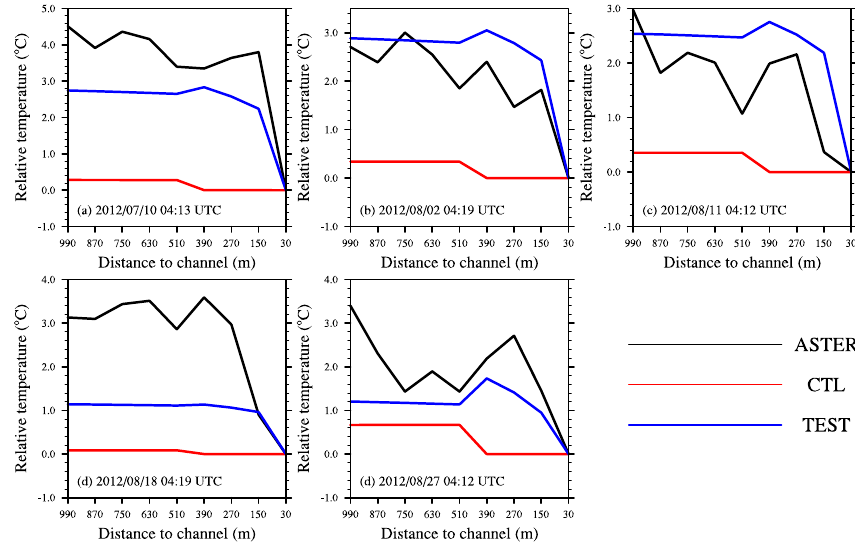
Figure 8. Relative ground temperature across the left riverbank of the 213 Bridge station from the CTL and TEST simulations and corre- sponding remote sensing data from five ASTER satellite transit events of (a) 10 July 2012 at 04:13UTC, (b) 2 August 2012 at 04:19UTC, (c) 11 August 2012 at 04:12UTC, (d) 18 August 2012 at 04:19UTC, and (e) 27 August 2012 at